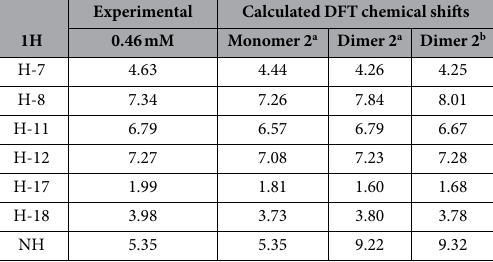
Table 7. Selected experimental and DFT calculated proton chemical shifts for Monomer 2 and Dimer 2 compared to the 0.46 mM colchicine in chloroform. a Calculated chemical shifts using mpw1pw91/6-311 + g(2d,p). b Calculated chemical shifts using wB97XD/6-311 + g(2d,p).